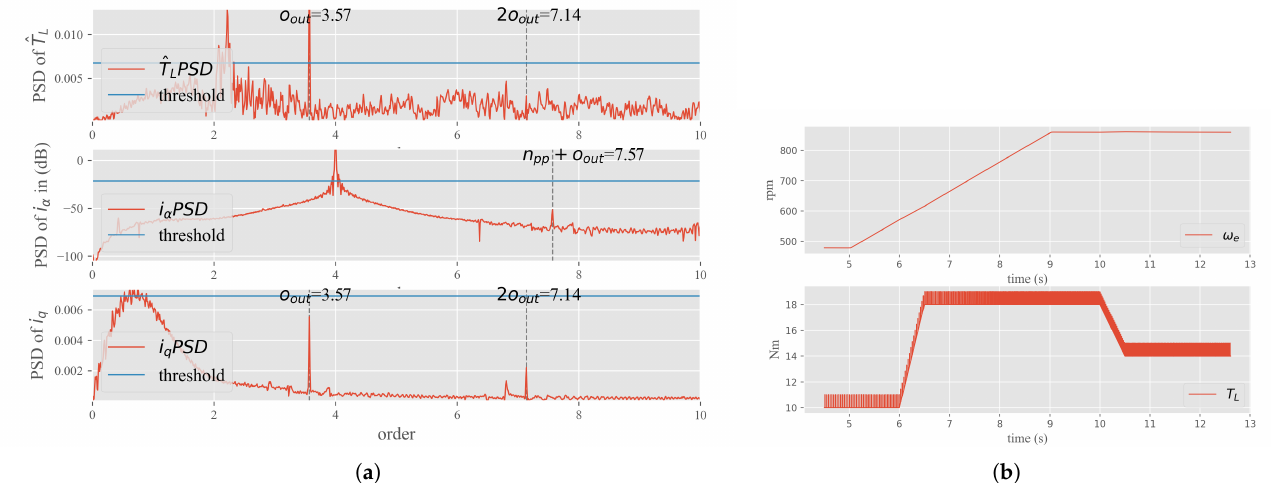
Figure 5. Simulation of the faulty motor ( a ) power spectrum density ( b ) graphical transients of speed and torque.